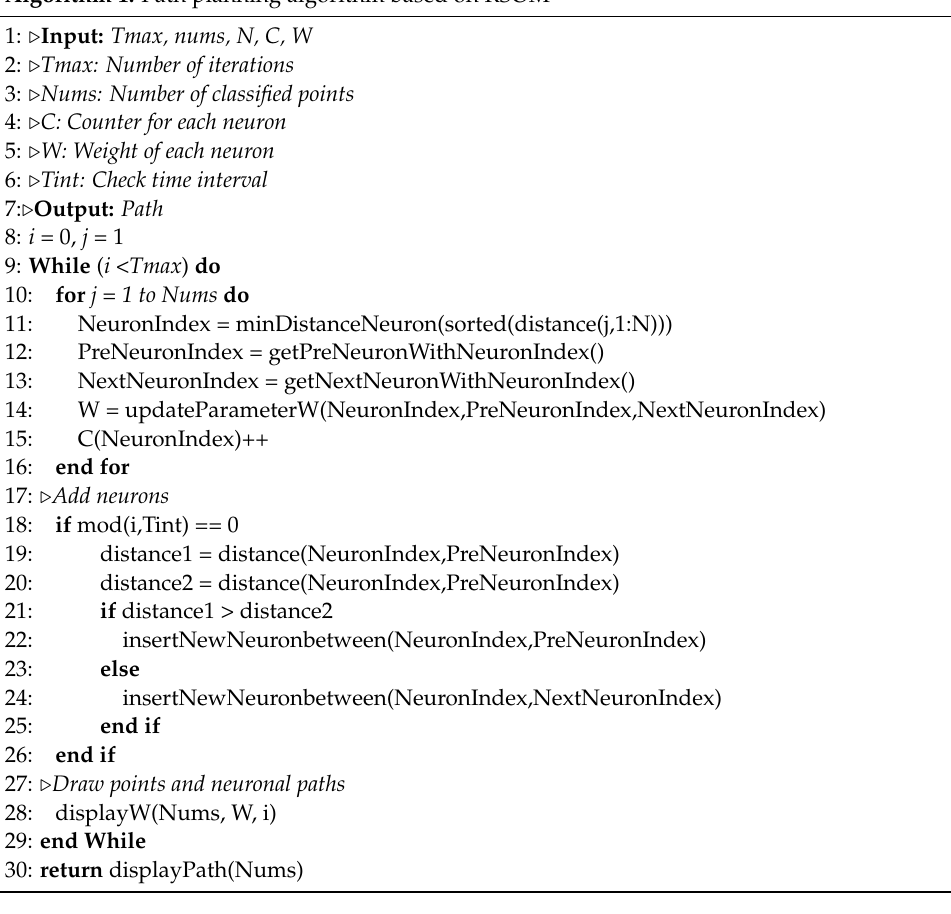
Algorithm 1: Path planning algorithm based on